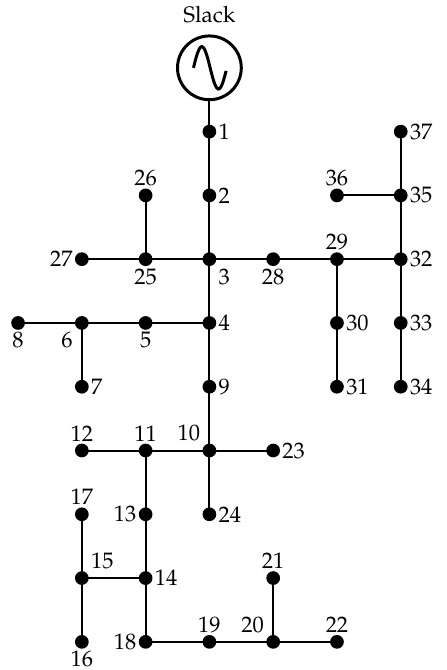
Figure 8. Electrical configuration of the 37-node